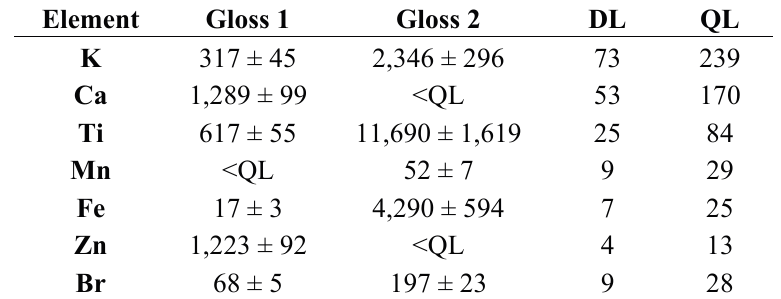
Table 4. Concentration results for the two lip gloss samples with the detection limit (DL) and quantification limit (QL). Values in mg·kg − 1